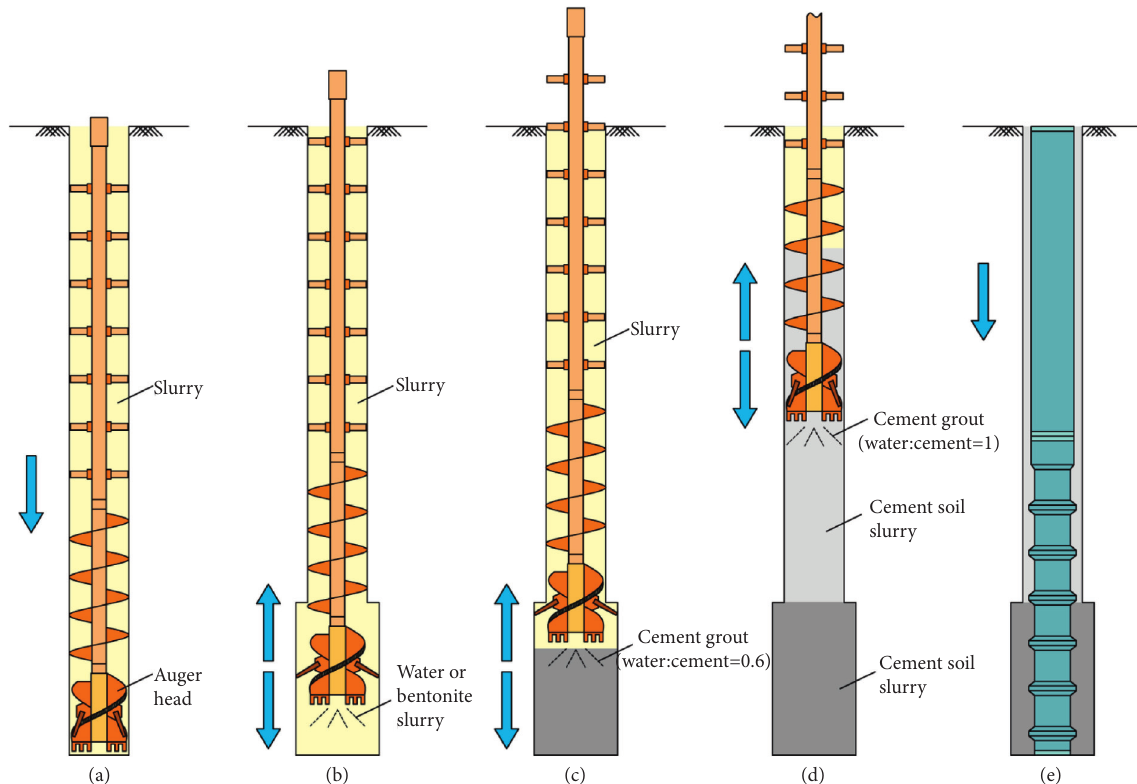
Figure 1: Typical construction sequence of a PPEB pile. (a) Drilling. (b) Expanding base. (c) Grouting at the enlarged base. (d) Grouting along the pile shaft. (e) Inserting the precast pile (modified from